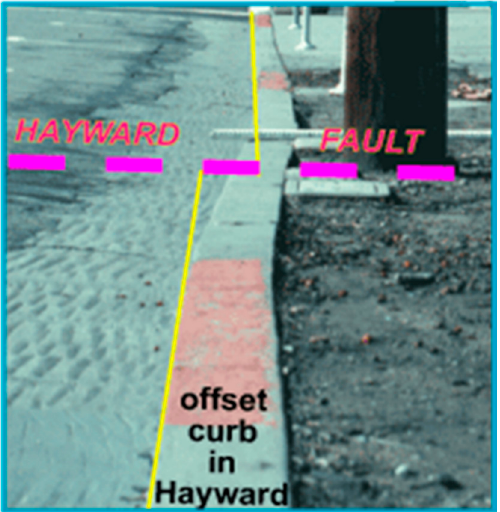
Figure 1. Evidence of fault creep in Hayward, CA, USA. Credit: U.S. Geological Survey (USGS) [3].